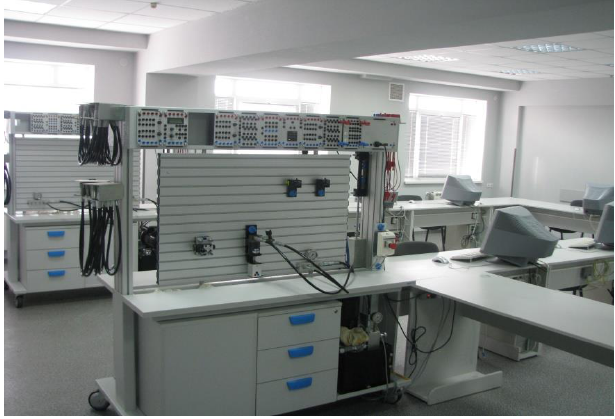
Figure 10. Two-way universal laboratory hydraulic